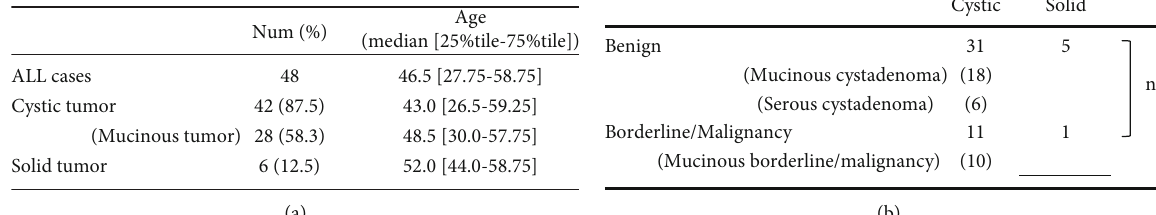
Figure 5: The frequency of cystic/solid tumors and borderline/malignant tumors among extremely giant ovarian tumors (ExG-OvTs). (a) Distribution of cystic/solid ExG-OvTs and their age. (b) The frequency of begin and borderline/malignancy in